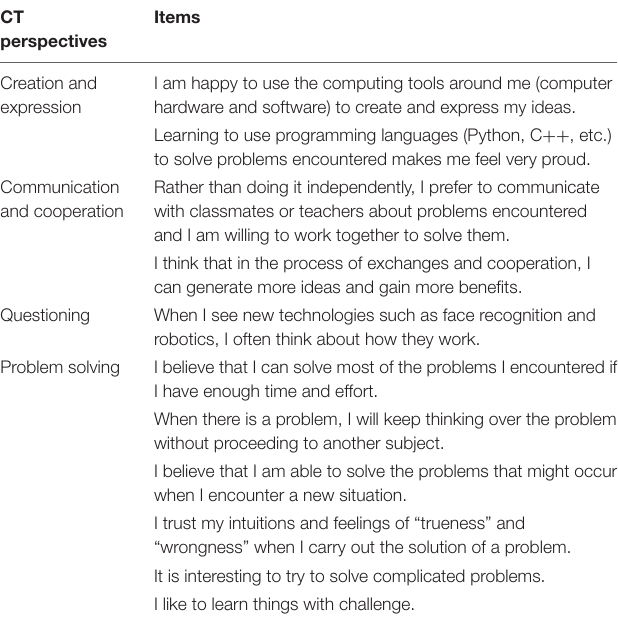
TABLE 6 | CT perspectives scale. TABLE 7 | The independent sample t -test of single-choice and program